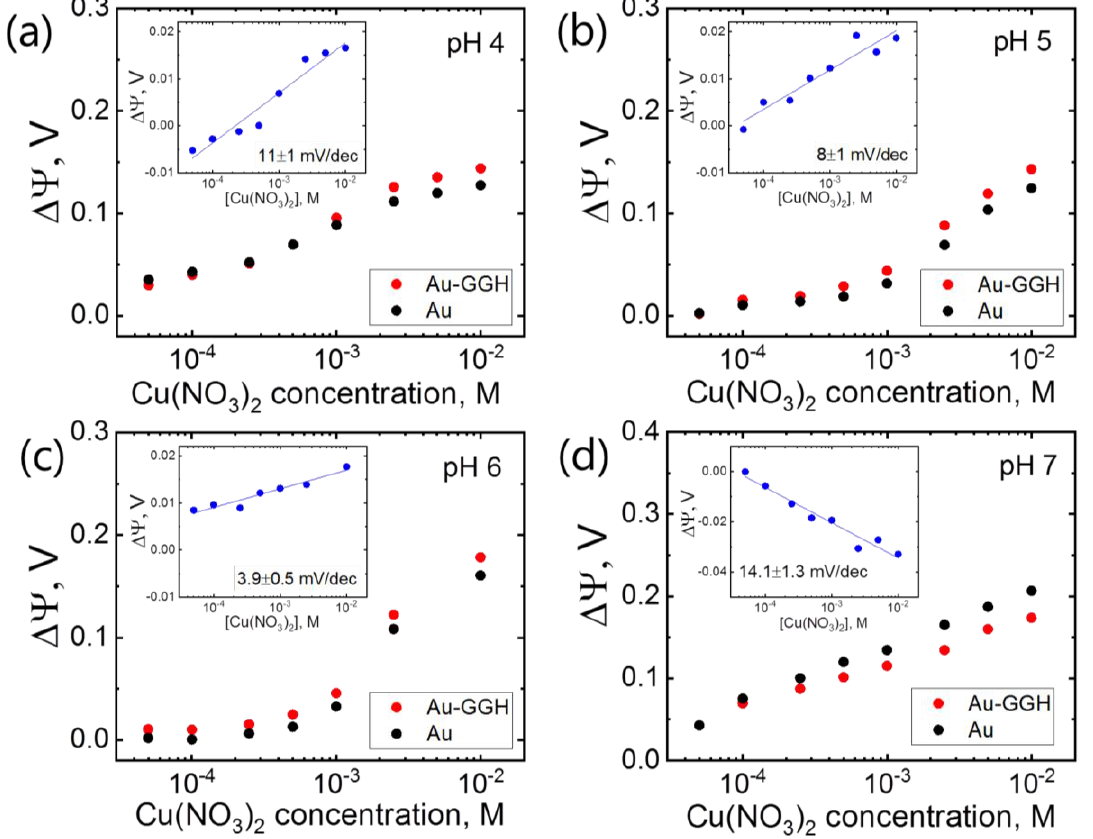
Figure. 3. Response to Cu 2+ ions at high concentrations (0.05–10 mM) in Titrisol buffer at ( a ) pH 4 (105 mM, HCl 0.044, NaOH 0.11, C 6 H 8 O 7 0.056 mol/l), ( b ) pH 5 (148 mM, NaOH 0.2, C 6 H 8 O 7 0.096 mol/l), ( c ) pH 6 (83 mM, NaOH 0.16, C 6 H 8 O 7 0.06 mol/l), ( d ) pH 7, ammonium acetate (50 mM). The signal is averaged over all measured nanoribbons (12 active and 12 control). All insets show the differential response.